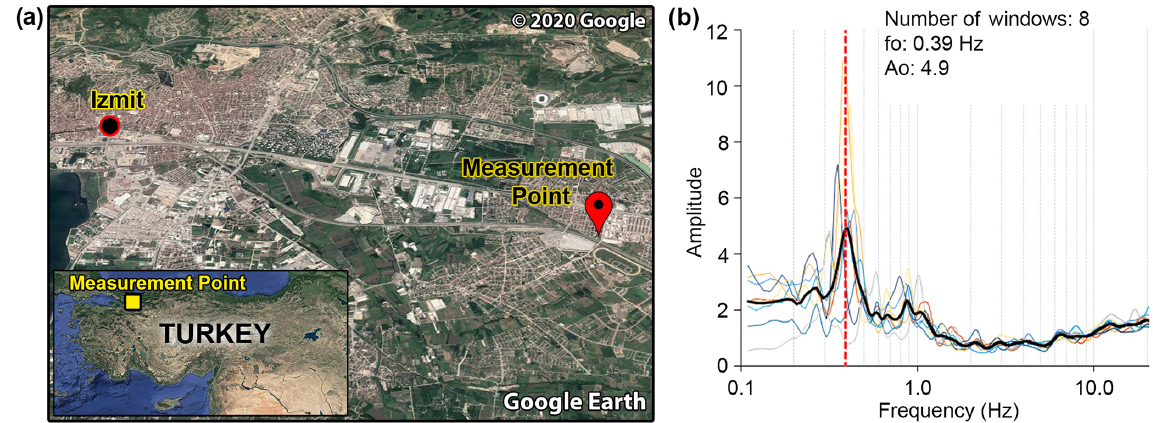
Figure 10. (a) Location of the test measurement point in Google Earth© view; (b) H / V spectral